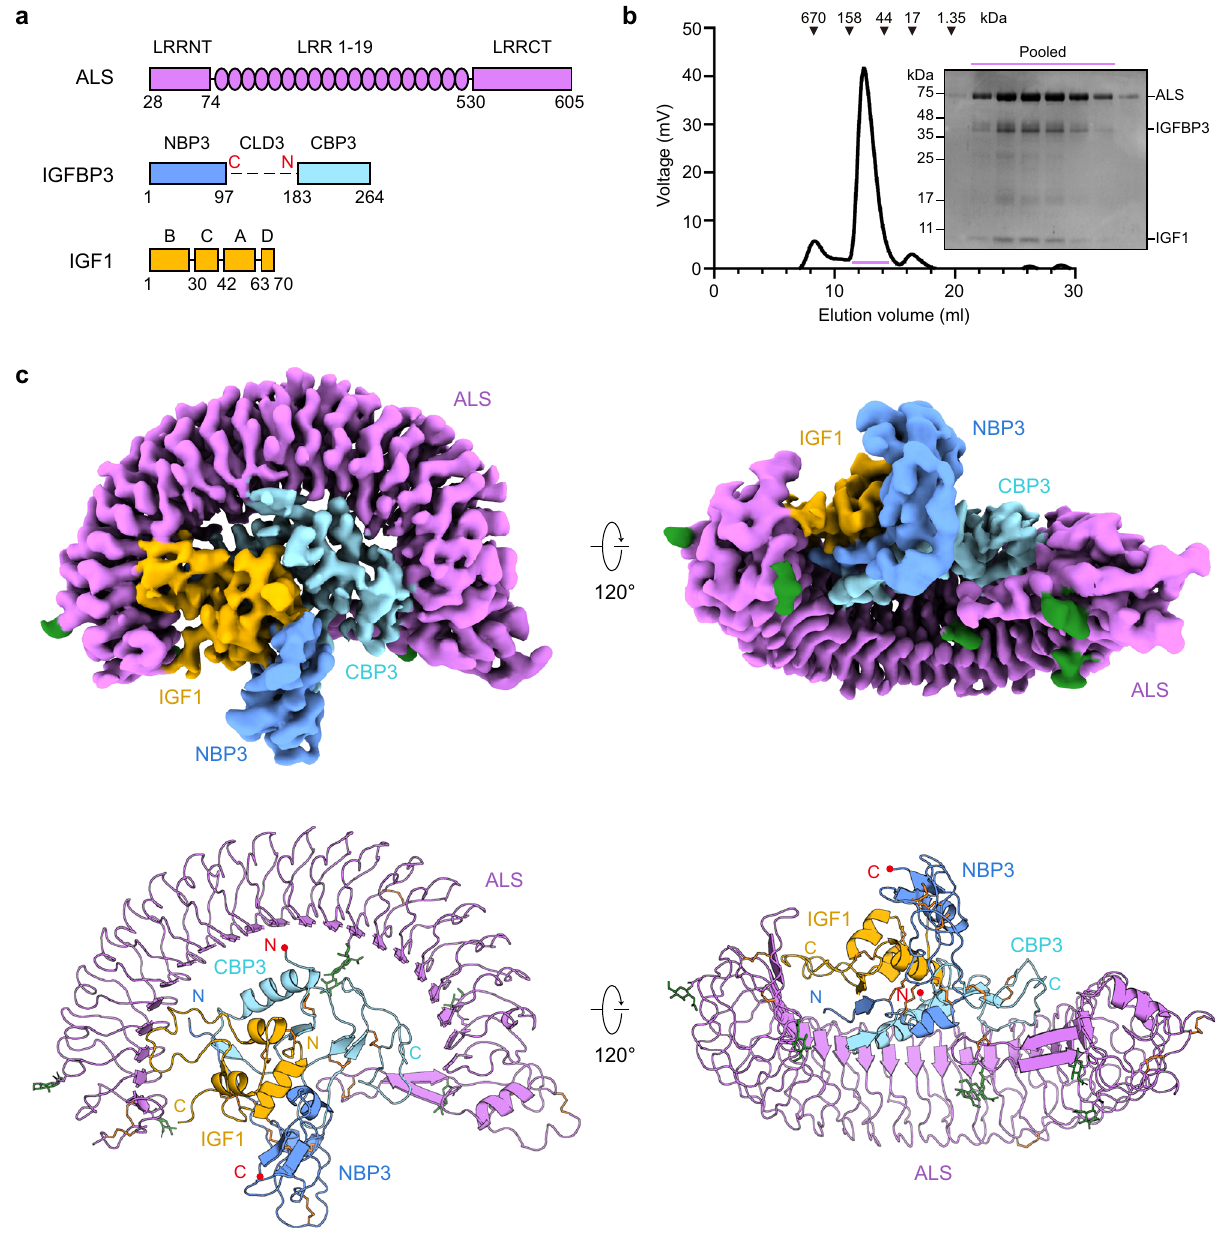
Fig. 1 | Overall structure of human IGF1/IGFBP3/ALS ternary complex. a SchematicdiagramofhumanALS,IGFBP3,andIGF1.Eachdomainislabeledabove the diagram, and the amino acids are numbered underthe diagram. In IGFBP3, the central linker domain, which was not resolved in the cryo-EM map, is shown as a dashedline.TheboundaryofthecentrallinkerdomainislabeledwitharedCandN, indicating the C-terminus of NBP3 and N-terminus of CBP3, respectively. b Size- exclusion chromatography (SEC) pro fi le of human IGF1/IGFBP3/ALS ternary com- plex(left)andSDS-PAGEanalysisoftheSECpeakfractionsstainedwithCoomassie